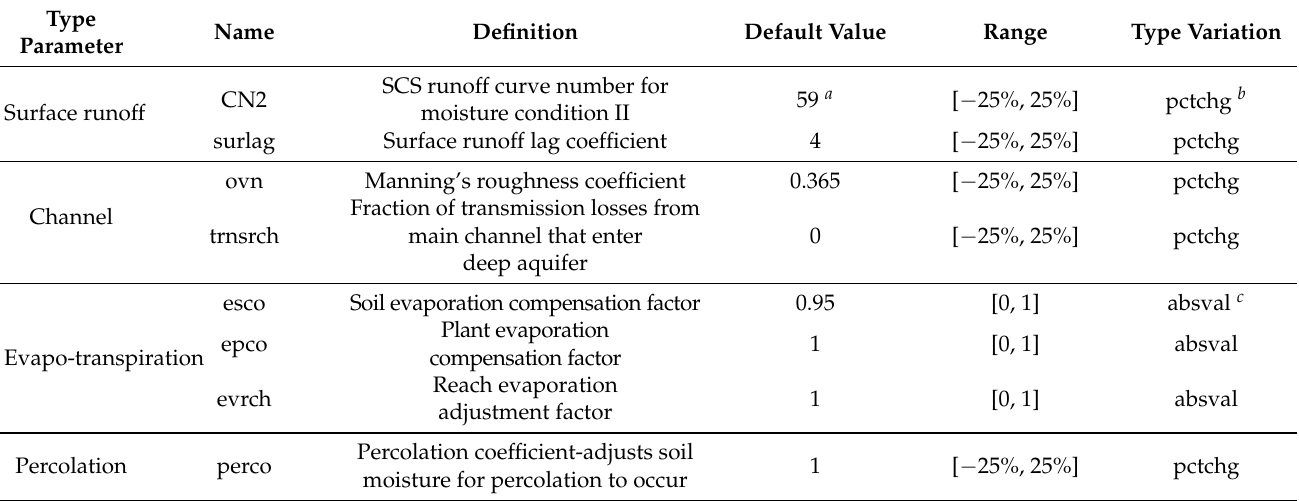
Table 4. Hydrological parameters, corresponding support (i.e., range of variability), and type of variation used in the sensitivity